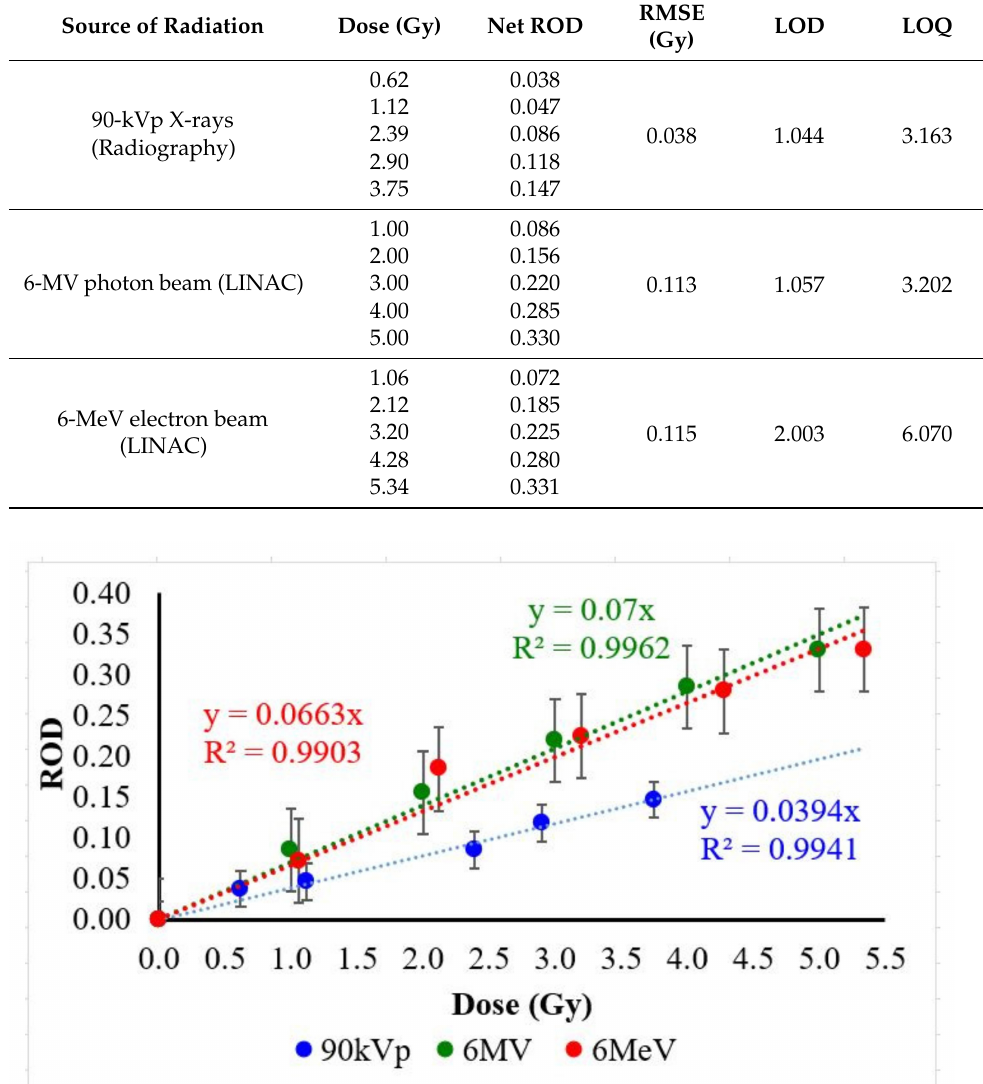
Table 6. Net ROD value for radiography X-rays, LINAC photon beam, and electron beam.